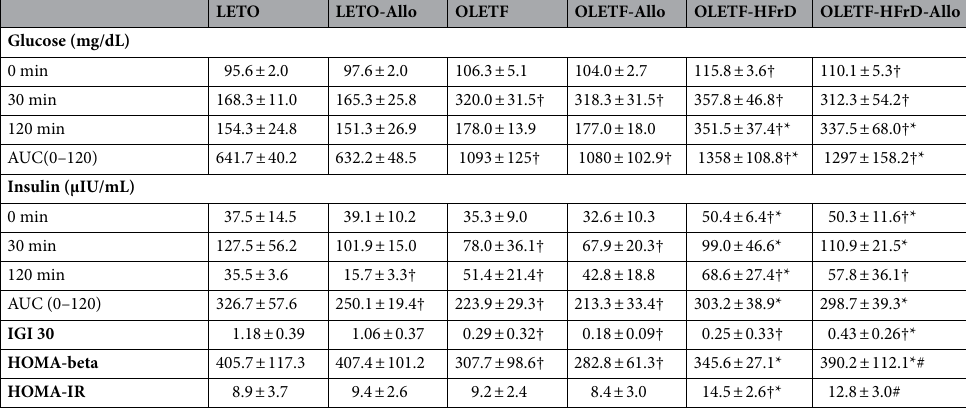
Table 2. Intraperitoneal glucose tolerance test-derived insulin sensitivity and secretion indices. Data are expressed as mean ± SE or median with interquartile range. LETO, Long-Evans Tohushima Otsuka; LETO- Allo, LETO rats treated with allopurinol; OLETF, Otsuka Long-Evans Tokushima Fatty rats; OLETF-Allo, OLETF rats treated with allopurinol; OLEFT-HFrD, OLETF rats fed with high fructose diet; OLETF-HFrD- Allo rats, OLETF rats fed with high fructose diet which were treated with allopurinol; HFrD, high fructose- diet; HbA1c, hemoglobin A1c; AST, aspartate aminotransferase; ALT, alanine aminotransferase. † P < 0.05 versus LETO group, * P < 0.05 versus OLETF group, # P < 0.05 versus OLETF-HFrD group.